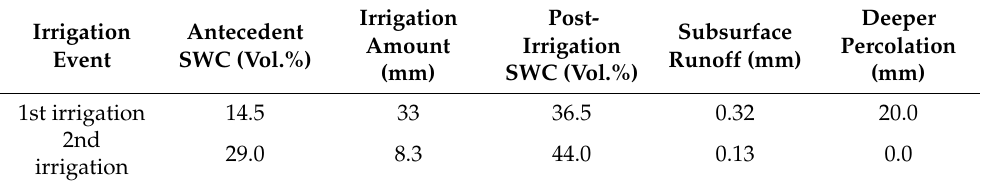
Table 3. Water balance in the irrigation experiment calculated for the forest floor horizon with a depth of 6 cm. Soil water contents are averages from 10 evenly distributed